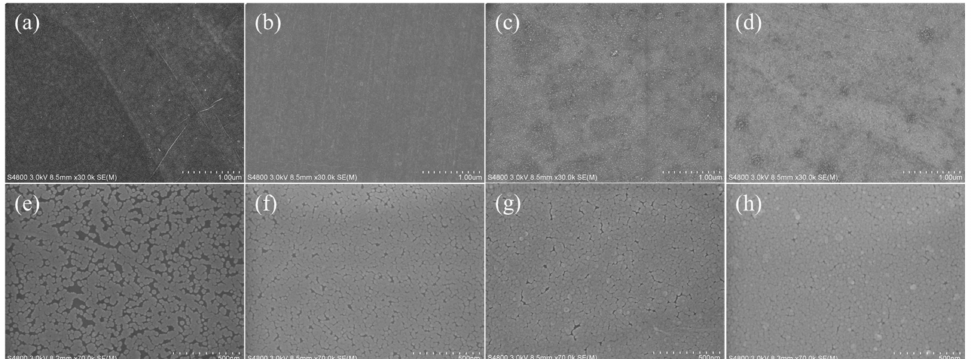
Figure 4. SEM images of samples etched with different conditions for 5 min at room temperature: ( a ) the etching of 2 nm self-oxidized Al 2 O 3 with solution A; ( b ) the etching of 2 nm self-oxidized Al 2 O 3 with solution B; ( c ) the etching of 5 nm self-oxidized Al 2 O 3 with solution B; ( d ) the etching of 10 nm self-oxidized Al 2 O 3 with solution B. SEM images of corresponding samples after further ALD of 10 nm Al 2 O 3 : ( e ) condition a; ( f ) condition b; ( g ) condition c; ( h ) condition